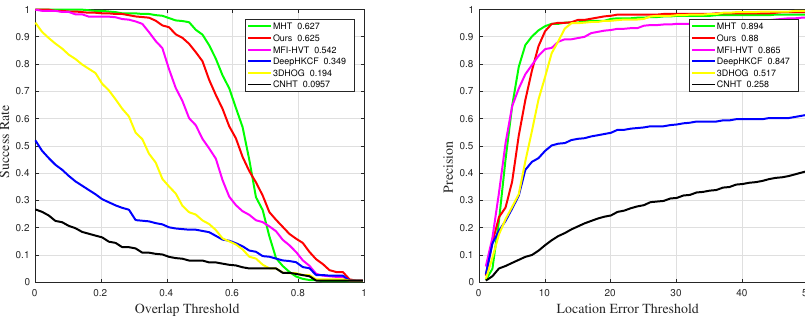
Figure 20. Quantitative results for sequences with challenge